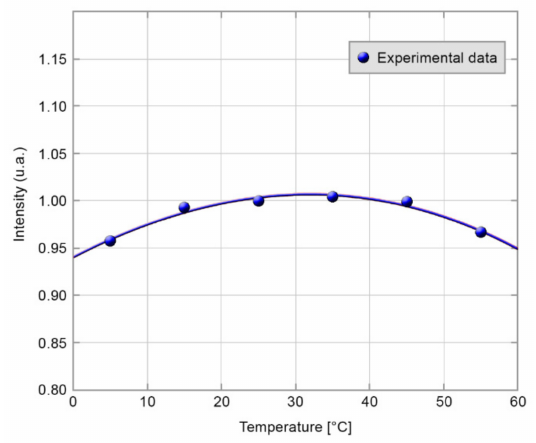
Figure 14. Stabilization of intensity as the temperature changes: experimental results.